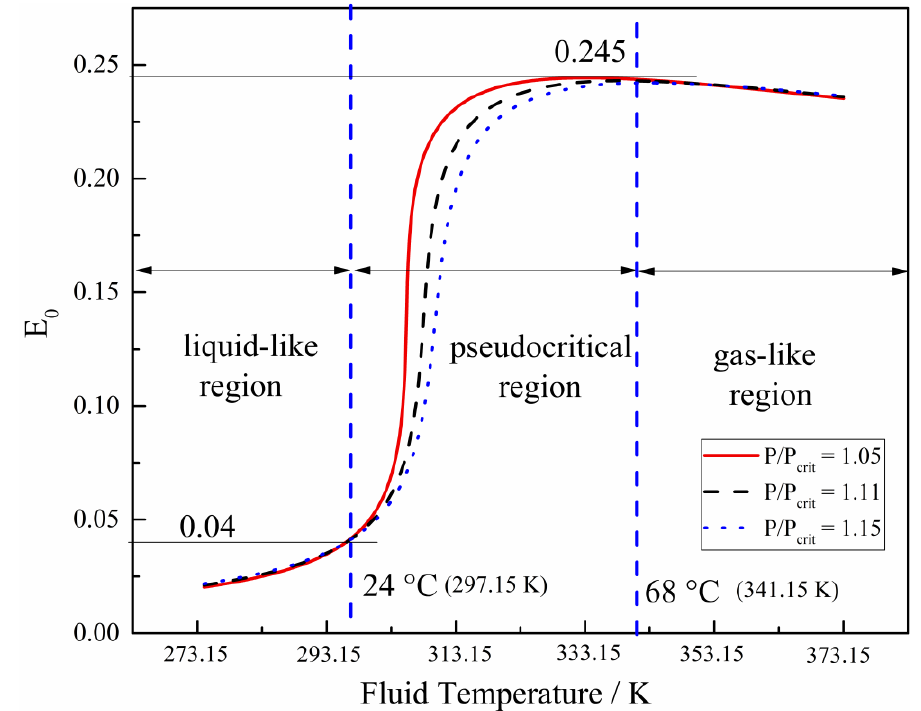
Figure 3. The region classification based on thermal expansion factors.